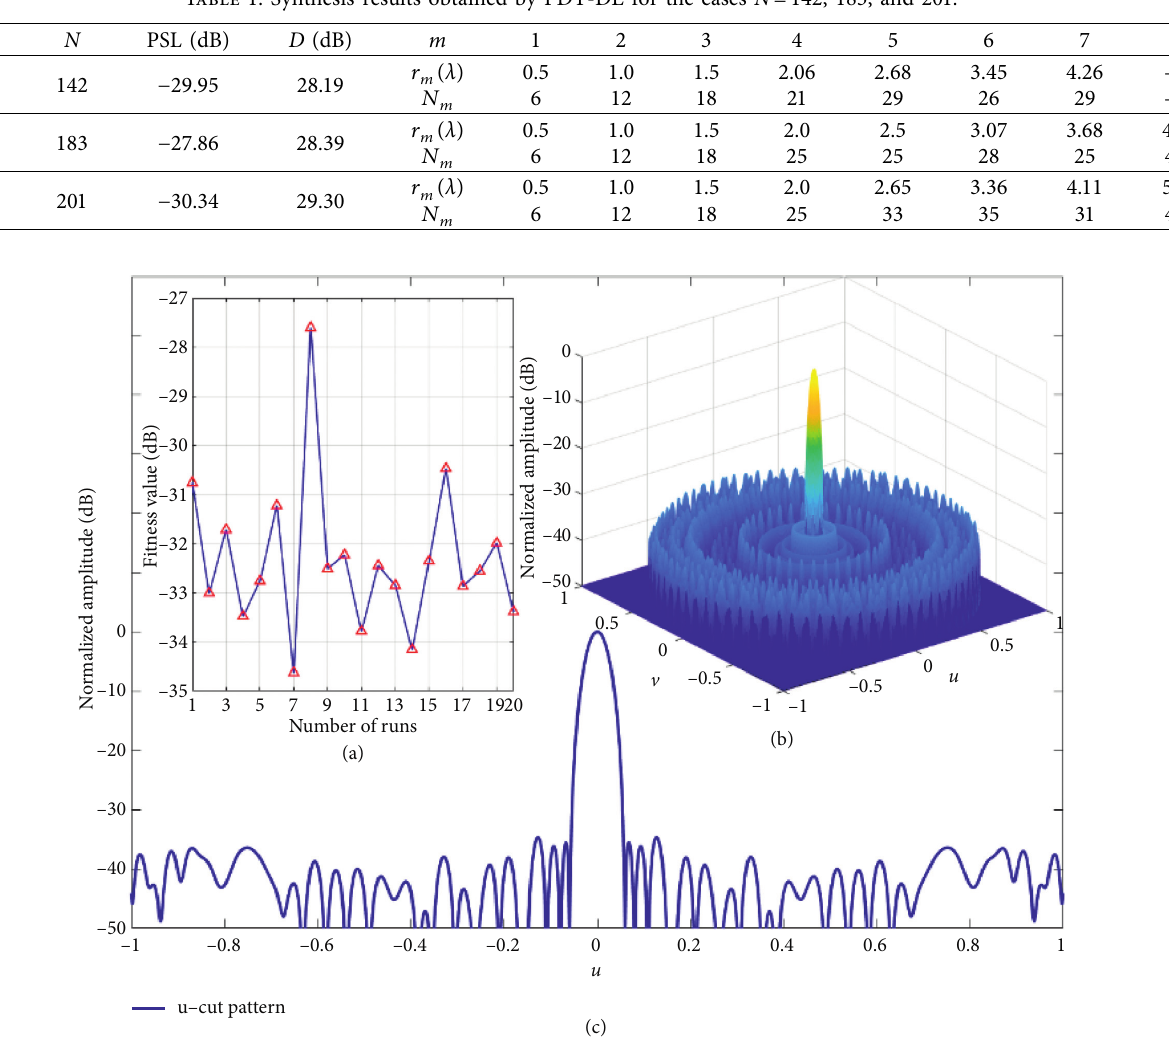
Figure 3: (a) Convergence of fitness value, (b) 3D pattern, and (c)